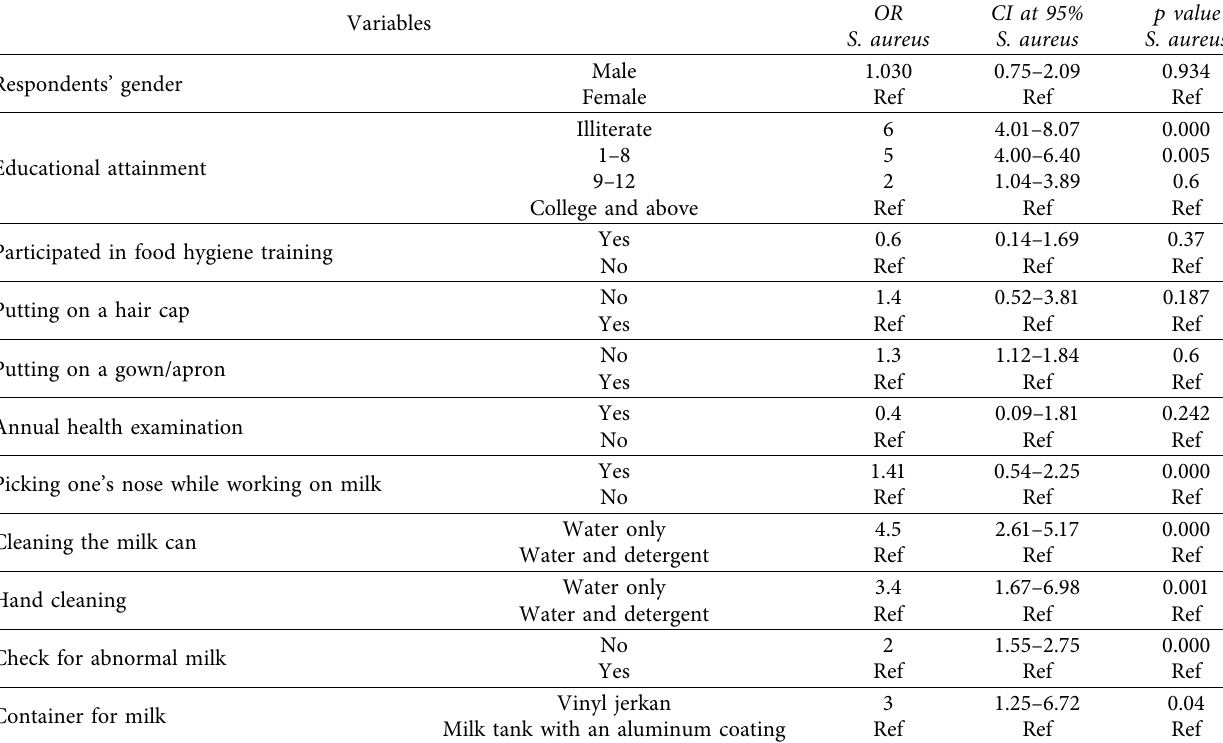
Table 4: Multivariable logistic regression analysis of S. aureus contamination in milk.